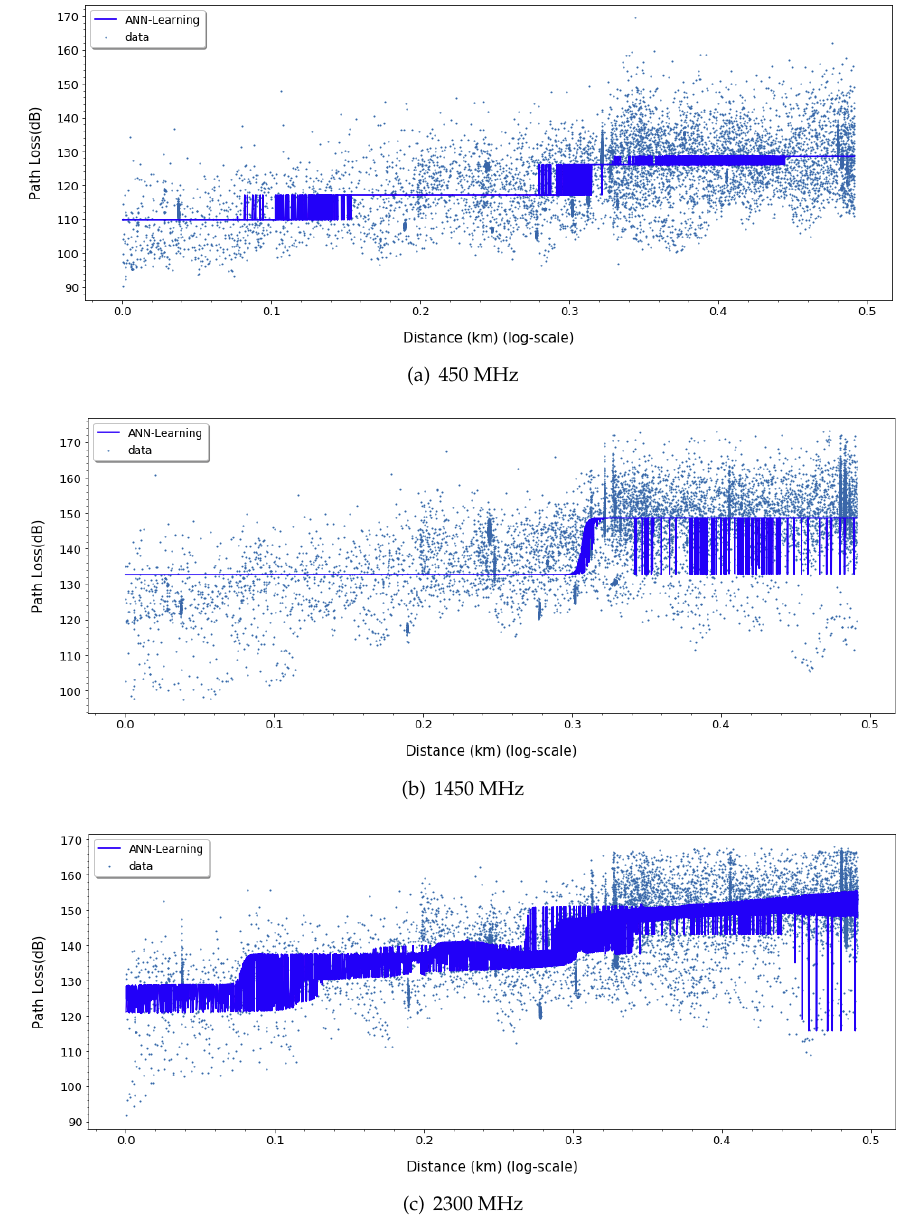
Figure 3. Four-feature-based ANN-MLP